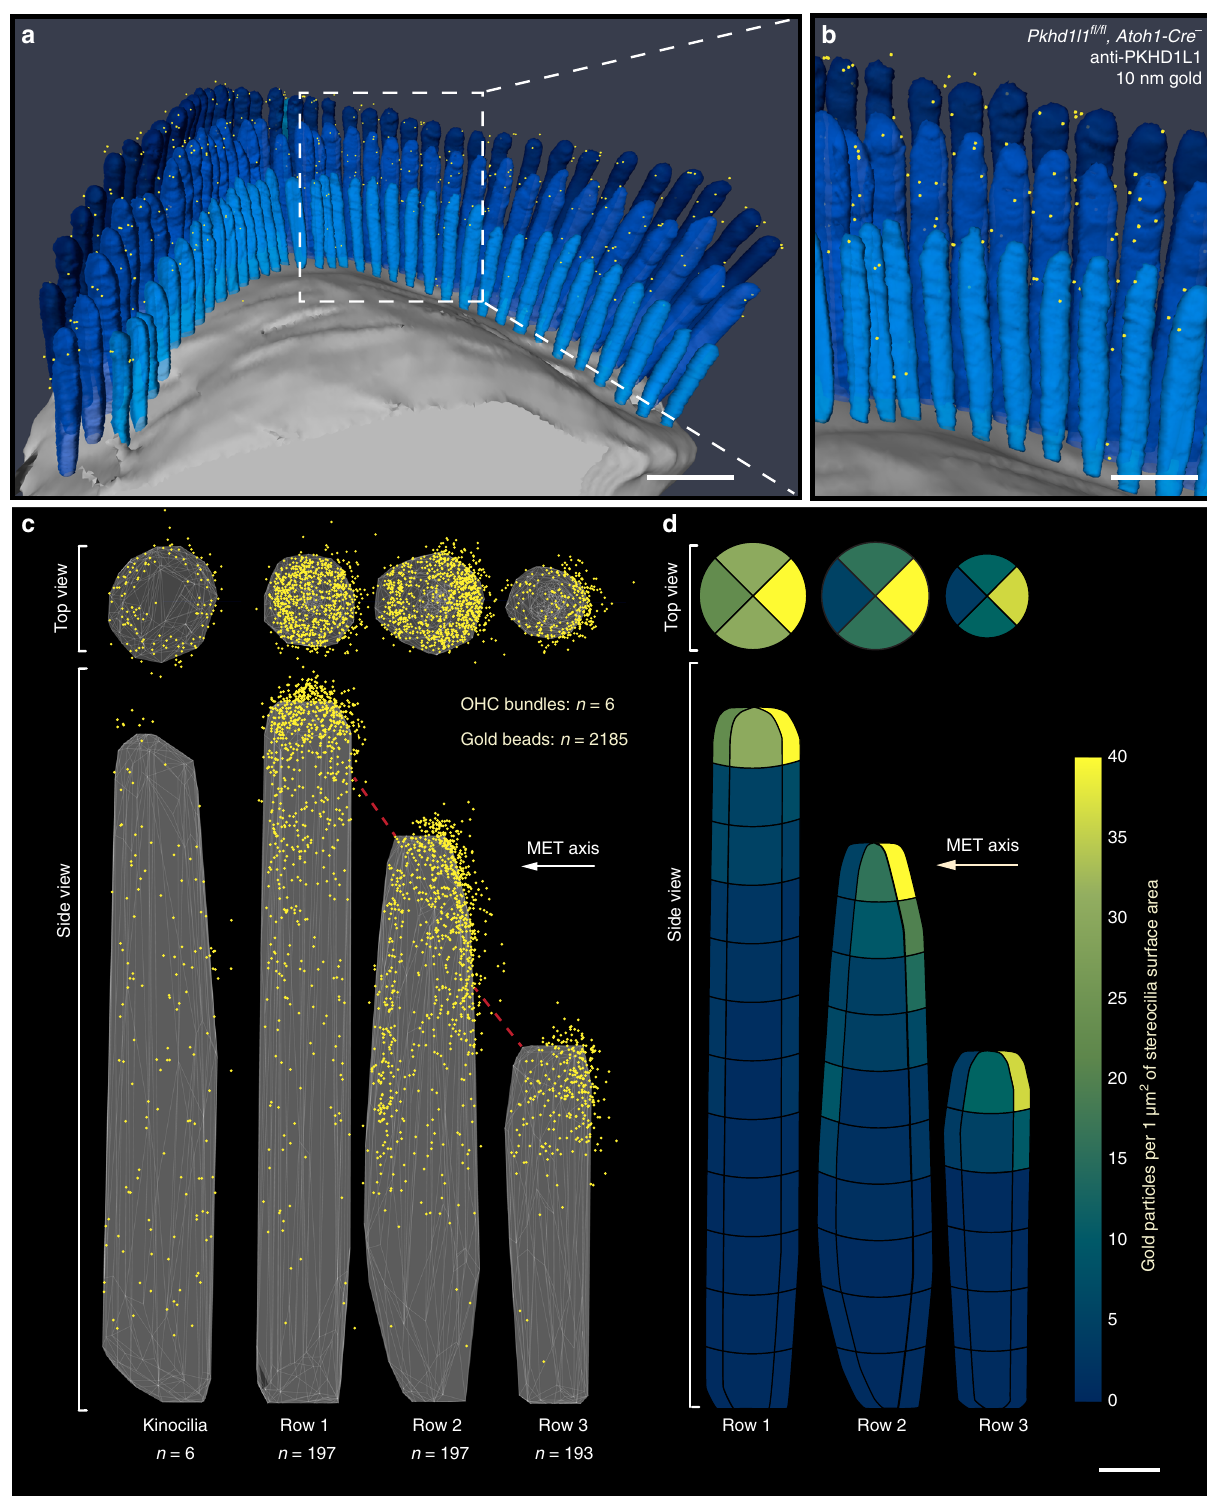
Fig. 5 3D localization of PKHD1L1 in P4 OHCs using immunogold FIB-SEM. a , b A 3D reconstruction of an anti-PKHD1L1 immunogold (10 nm)-labeled OHC stereocilia bundle (387 serial FIB-SEM cross-sections, at 15 nm milling step; yellow, gold beads; blue, stereocilia; gray, cell body). c A 3D cumulative distribution map of anti-PKHD1L1 immunogold beads generated with a custom MATLAB algorithm from six reconstructed OHC stereocilia bundles. Top and side views are shown for all three rows of stereocilia (yellow represents gold beads; gray triangles represent the stereociliary surface; red dashed lines represent tip links. Kinocilia (left) were excluded from further analysis due to a low number of observations. d Density of anti-PKHD1L1 immunogold beads (beads µ m − 2 of stereociliary surface area). Same data as in c , calculated as an average density of beads within 12 (tallest row), 10 (middle row), or 6 (shortest row) equally tall segments of stereocilia. Each segment was further divided into four radial sectors, as seen in the top-view panel. Scale bars: a , 1 µ m; b , 500 nm; d, 200 nm. Source data are provided as a Source Data fi